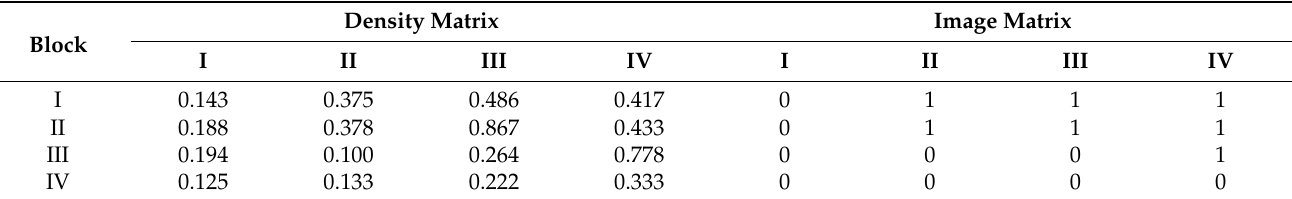
Table 6. Density matrix and image matrix of agricultural water use efficiency in